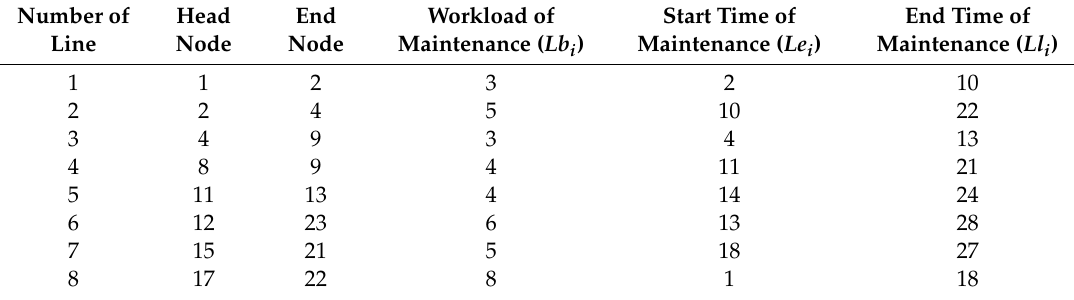
Table 1. Information of the overhead transmission lines to be